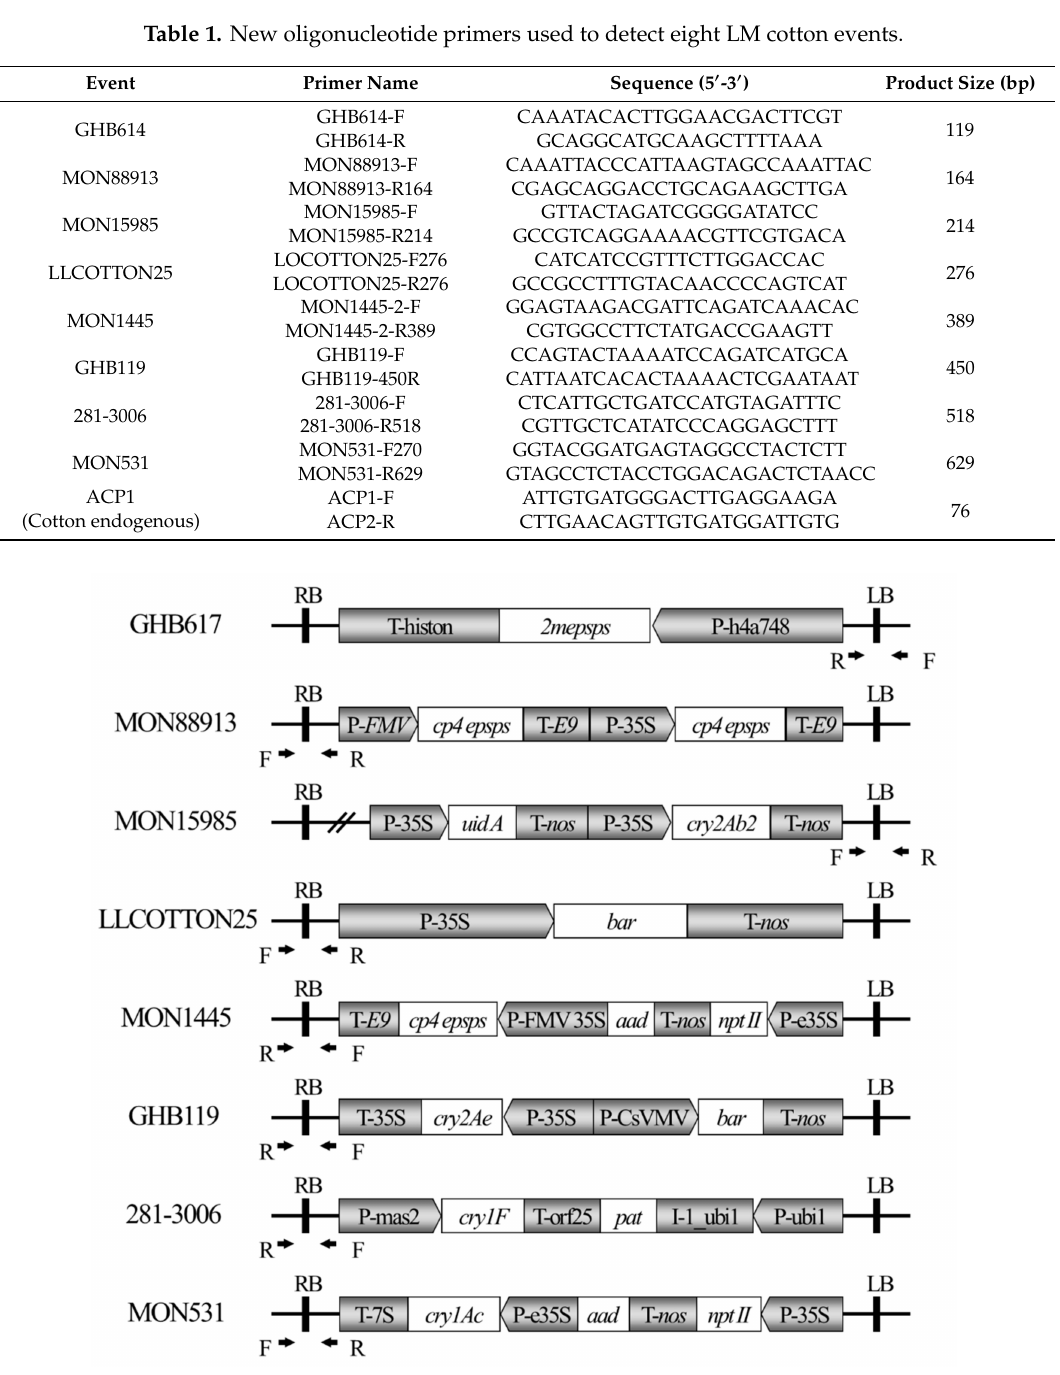
Figure 2. Schematic representations of the PCR primer positions for multiplex PCR of eight LM cotton events. Sites and direction of primers are indicated by black arrows. All primer pairs were designed with the DNA flanking region of the cotton genome and inserted DNA cassette. (LB: Left border; RB: Right border; F: Forward primer; R: Reverse primer; gray pentagon: Promoter; white square: Encoding gene; gray square: 3 (cid:48)